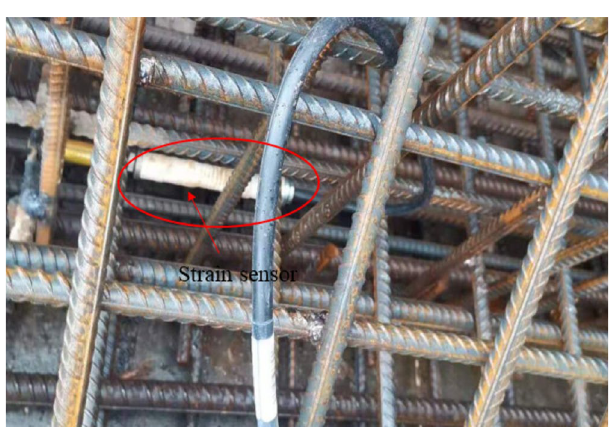
Figure 17. The scene of the concrete stress sensor.